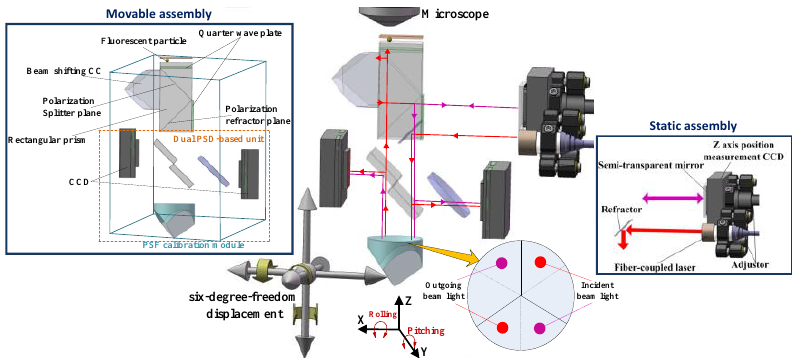
Figure 2. Proposed point spread function (PSF) measurement setup and light routes (red / purple arrows). ThePSF calibrationmodulewasintegrally fixedona six-degree-freedommacro / microdisplacement platform. The slope face of the rectangular prism containing the polarization refractor plane